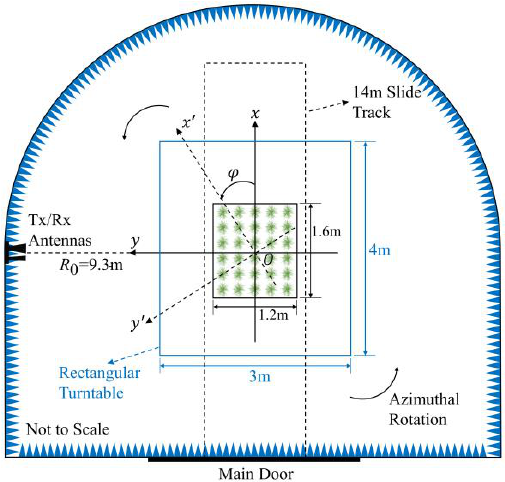
Figure 5. Rice field scene measurement setup (top view). Table 2. Measurement parameters of the two rice field scenes.